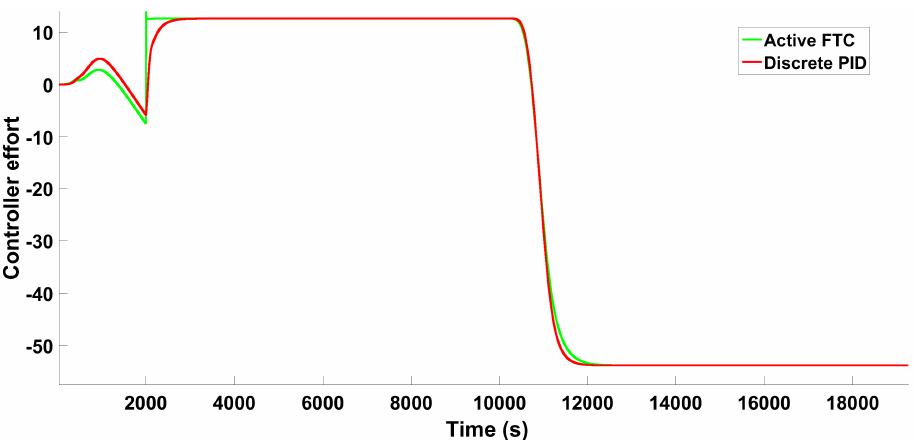
Figure 12. Scenario 1 − Ramp-type fault: Control signals applied on the reduced model (Hammerstein − Wiener).